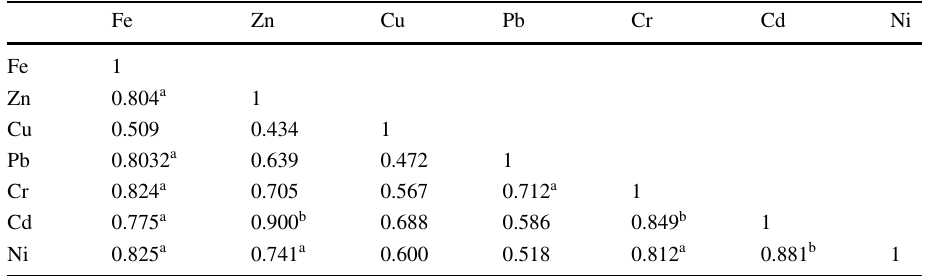
( r ) matrix of heavy metals in Awash River during dry season